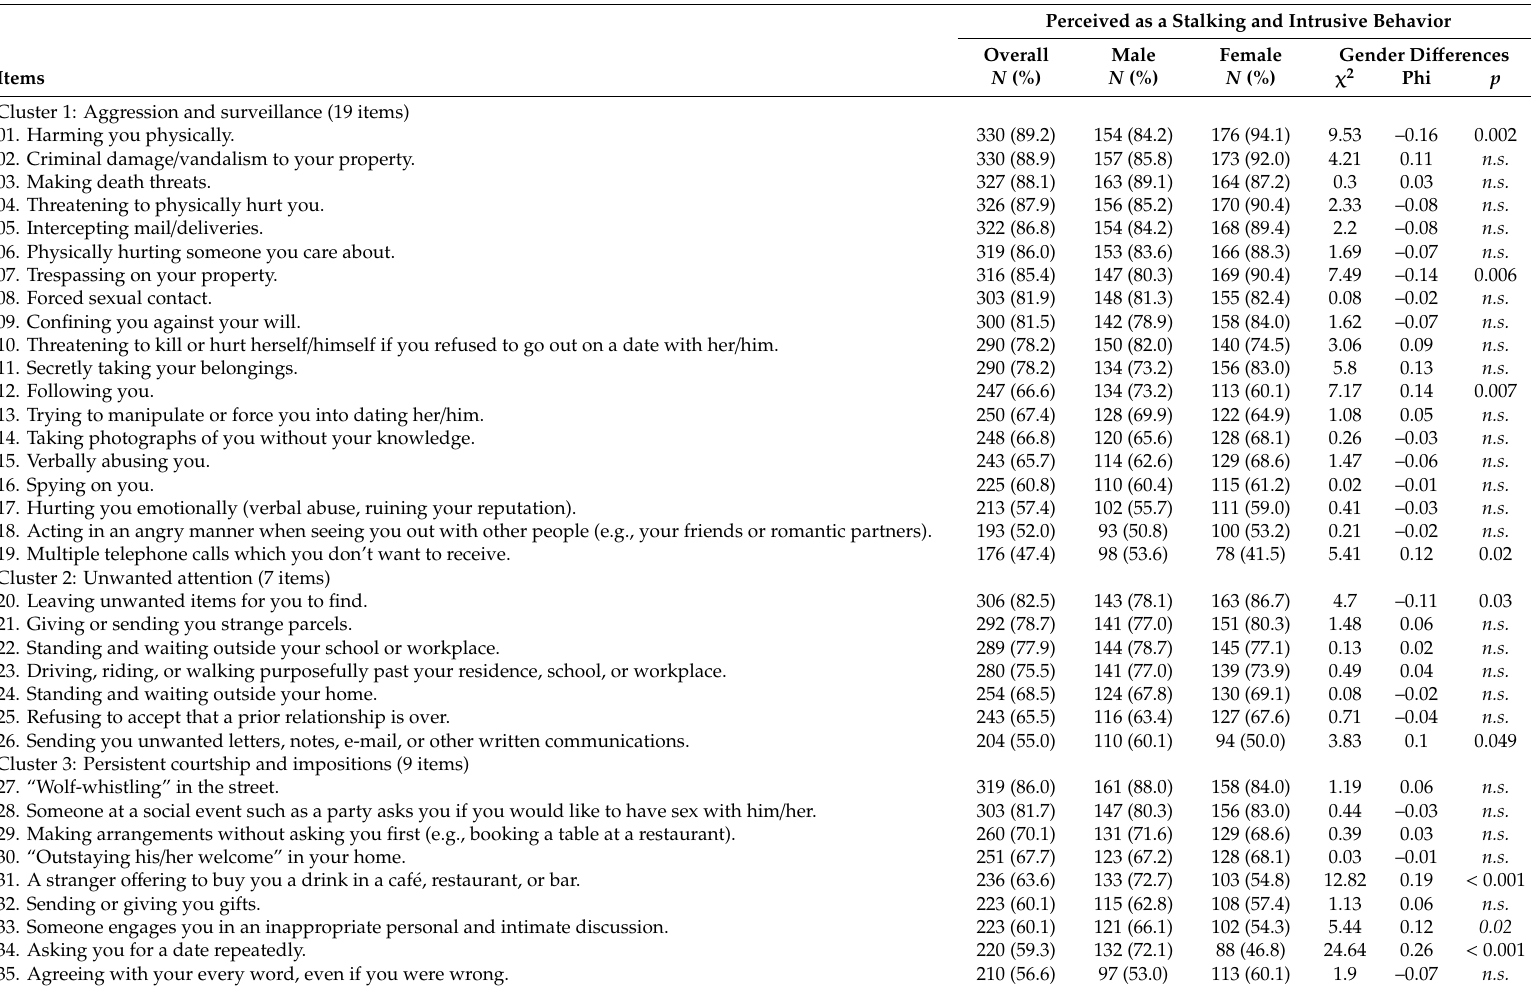
Table 2. Gender di ff erences on experiences of stalking and intrusive behavior ( N = 371). Perceived as a Stalking and Intrusive Behavior Overall Male Female Gender Di ff erences Items N (%) N (%) N (%) χ 2 Phi p Cluster 1: Aggression and surveillance (19 items) 01. Harming you physically.